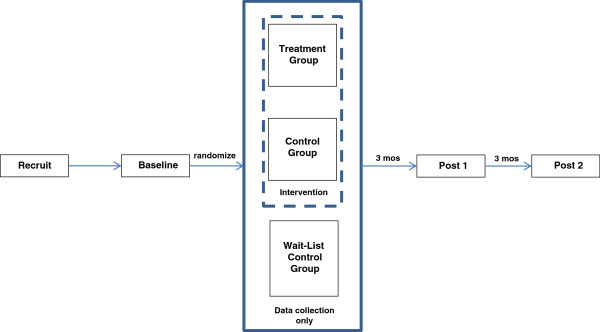
Research design.